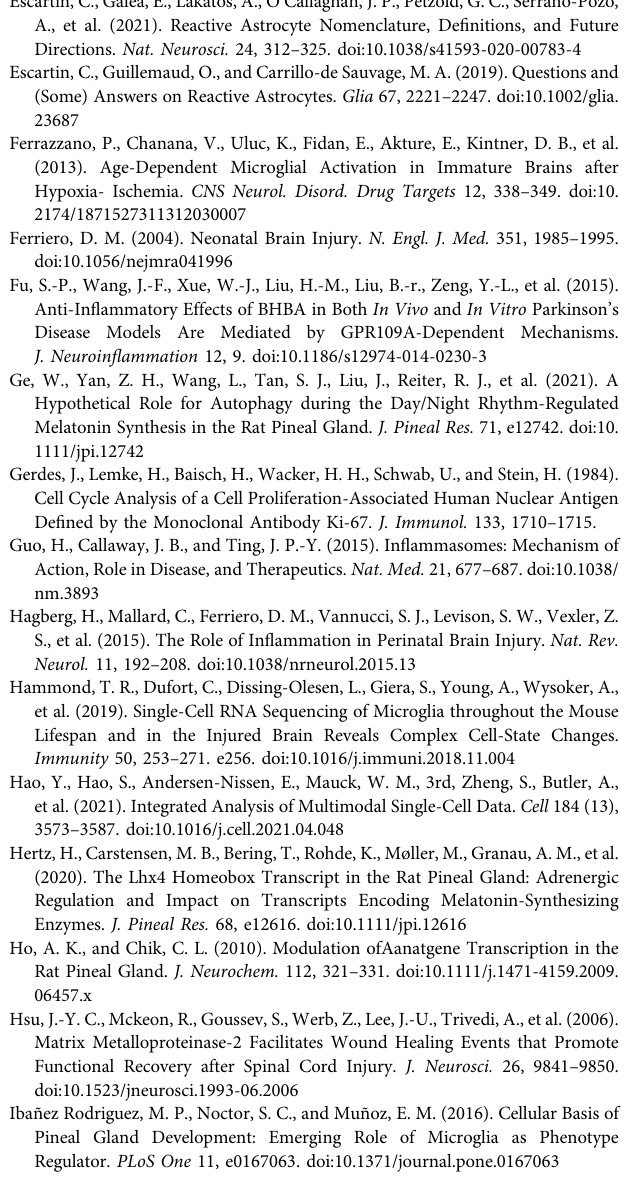
transverse sections of the pineal gland showing a negative control (PBS, left) and a positive control (DNase I treated, right) of the TUNEL staining. Scale bar: 200 μ m. n=5,5 for sham and HIBD animals, 5 sections crossing the pineal gland were used for individual animals, Student ’ s t test, n.s., no statistical signi fi cance. Supplementary Figure S3 | Assessment of microglia pyroptosis at different time points post HIBD. (A-B) Representative images of transverse sections of the pineal gland with immunostaining against Iba1 and Caspase-1 at 24 h (A) or 72 h (B) post sham or neonatal HIBD, respectively. Arrowheads indicated co- labeling of Caspase-1 and Iba1. Scale bar: 200 μ m. (C) Quanti fi cation of relative fl uorescent intensity of Caspase 1 (left) and percentage of & Iba1 + / Caspase-1 + cells (right) in the pineal gland at 24 h or 72 h post sham or neonatal HIBD, respectively. n=3,3 for sham and HIBD animals, 5 sections crossing the pineal gland were used for individual animals, Student ’ s t test, **, P <